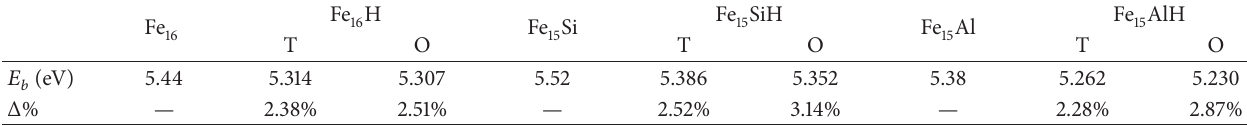
Table 5: Calculated binding energy of supercells, eV.